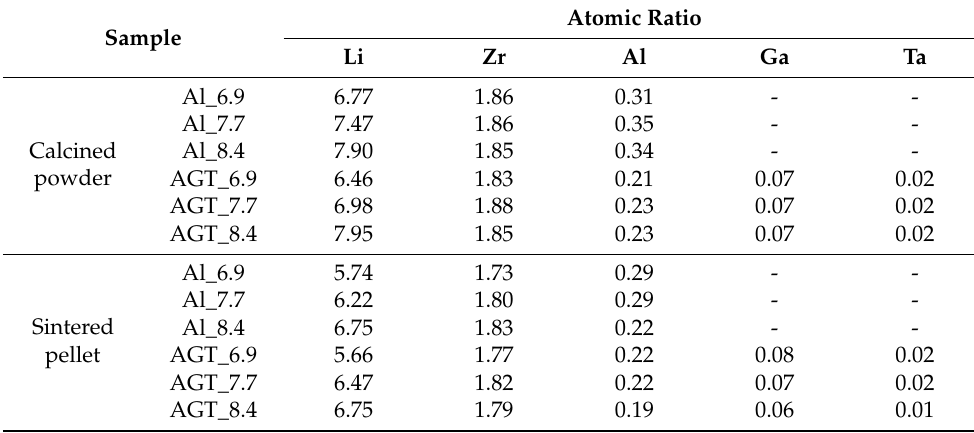
Table 1. Composition of calcined powders and sintered pellets by ICP-AES.